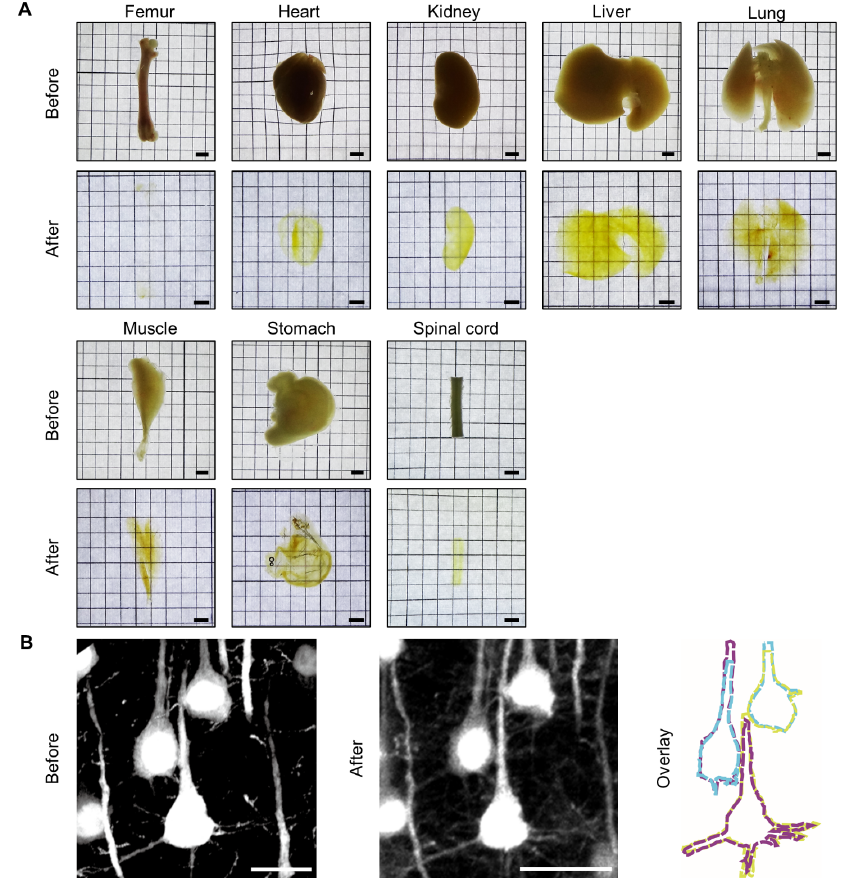
Figure 3. The clearing performance on different tissues/organs using tDISCO clearing. ( A ) Images of individual mouse organs before and after tDISCO clearing. ( B ) The neuronal morphology before and after tDISCO clearing. The outlines of three individual neurons before and after clearing were matched, the yellow, blue, and magenta colors (left) versus blue, magenta, and yellow colors (middle), separately. Scale bars: ( A ), 2 mm; ( B ), 20 μ m.